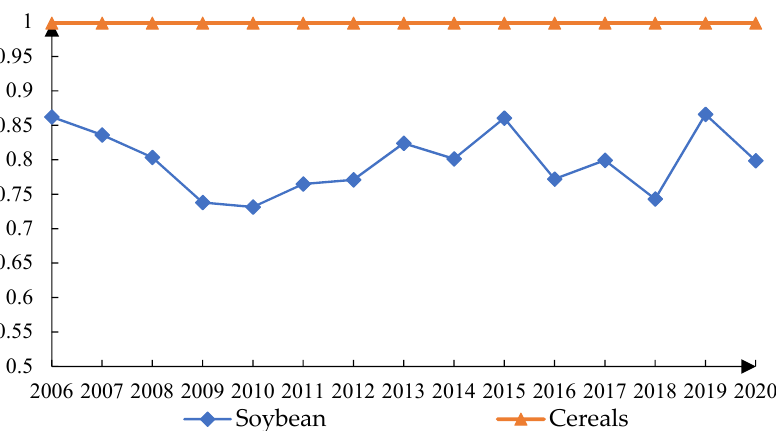
Figure 5. Trends in fertilizer use efficiency in the production of different grain types. The cereals FEI is the average of FEI for three crops: corn, rice, and wheat. The FEI levels of wheat, corn, and rice are relatively close and trend in the same direction, making them difficult to distinguish in the figure. Therefore, the cereal FEI is used in the figure to replace the three crop FEIs.